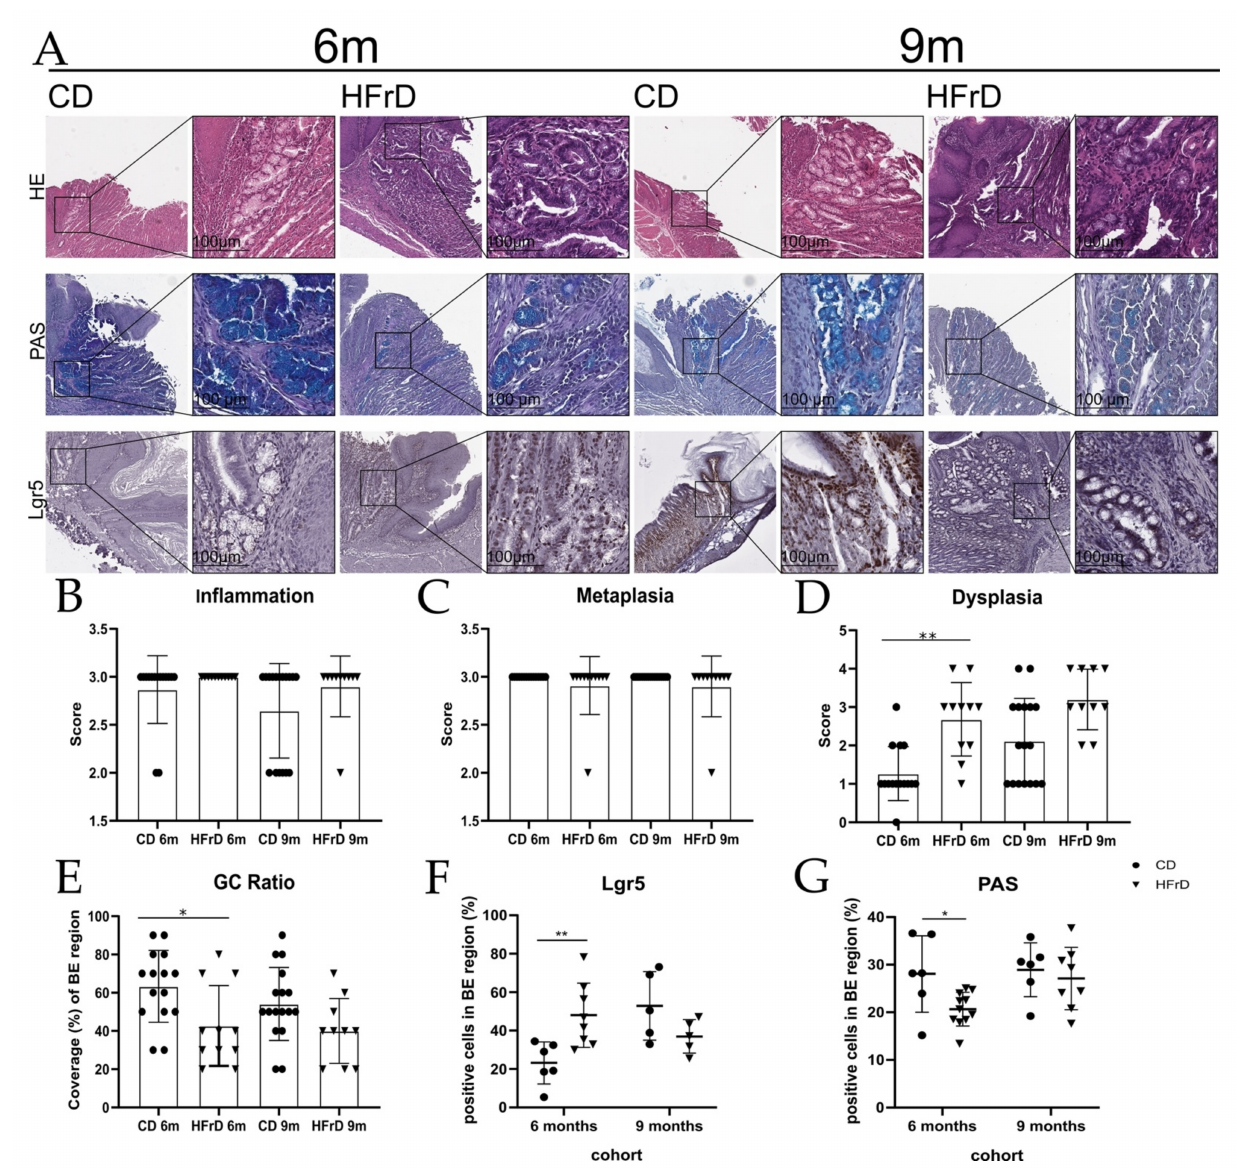
Figure 1. Histologic tumor scores, stem cell expansion, and proportion of mucus-producing goblet-like cells in the BE region. ( A ) Microscopic pictures of HE, PAS, and Lgr5 staining; analysis of histologic tumor scores of the BE region: ( B ) inflammation score, ( C ) metaplasia score, ( D ) dysplasia score, and ( E ) goblet-cell (GC) ratio. Inflammation and metaplasia-scores of mice from the different intervention groups and cohorts did not differ. While the dysplasia scores of 6-month-old HFrD mice significantly increased ( p = 0.0079) in comparison with CD mice, the GC ratio was significantly smaller ( p = 0.0435) in 6-month-old HFrD compared with CD mice. In 9-month-old mice, dysplasia scores and GC ratio failed to reach significance; ( F ) analysis of Lgr5-positive cells in the BE region. While the percentage of Lgr5-positive cells was significantly higher ( p = 0.0083) in 6-month-old HFrD-fed mice than in CD mice, there was no difference in the older mice; ( G ) analysis of mucus-producing goblet-like cells in the BE region. While the area of PAS-positive cells in the BE region was significantly smaller in 6-month-old HFrD compared with CD mice ( p = 0.0176), the effect did not reach significance in the 9-month-old